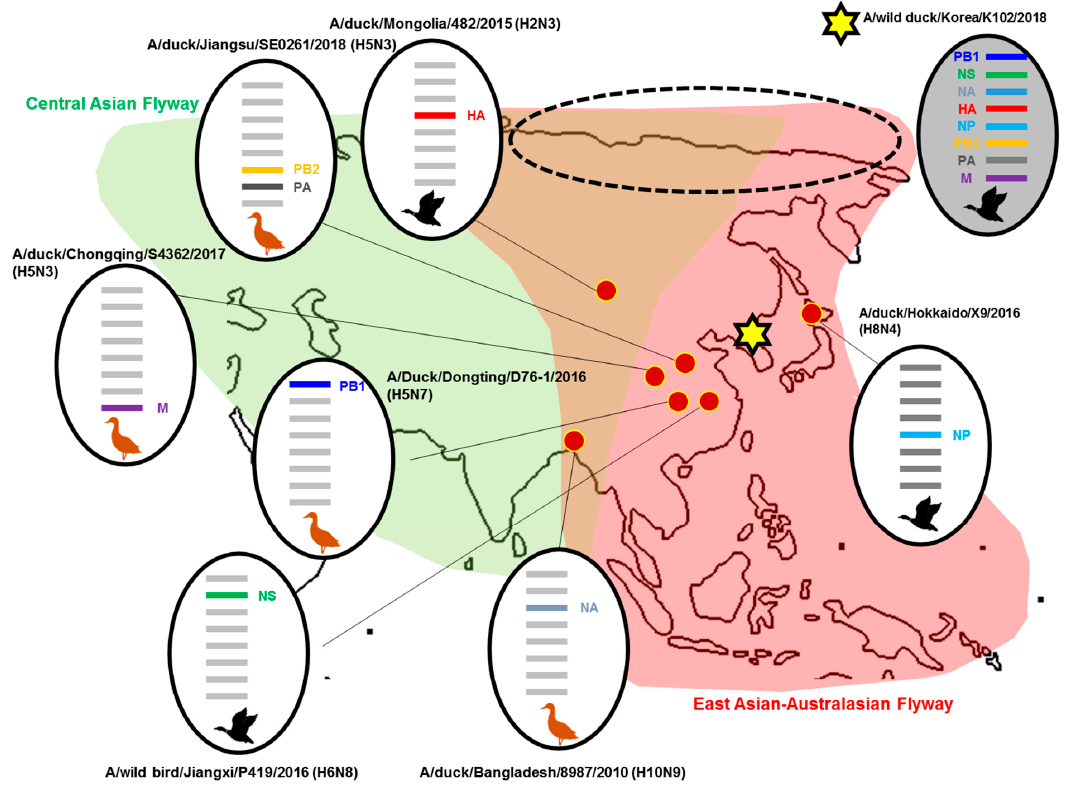
Figure 1. Location of putative origins of genomic compositions of the A/wild duck/Korea/K102/2018 (H2N9). Dotted circles indicate the multiple converging flyways in which reassortments occur.